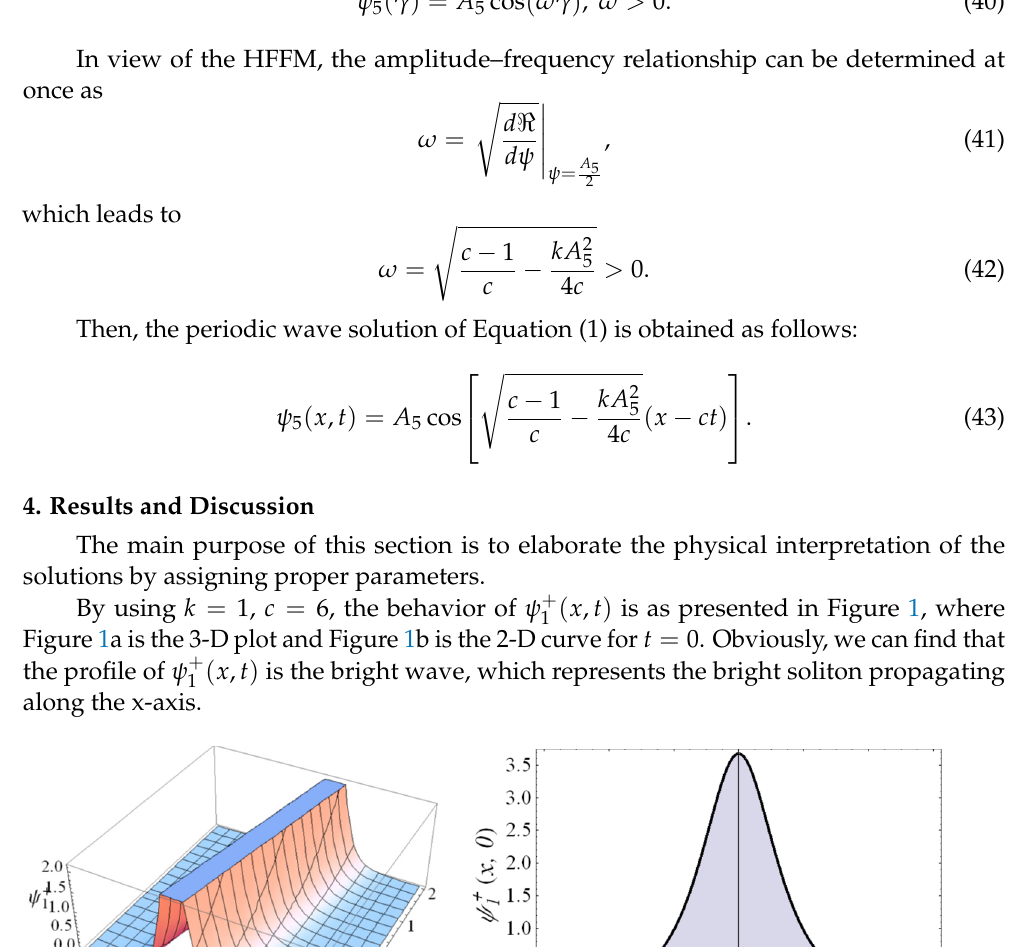
Figure 1. The dynamic characteristics of ψ + = t t = for 0 .